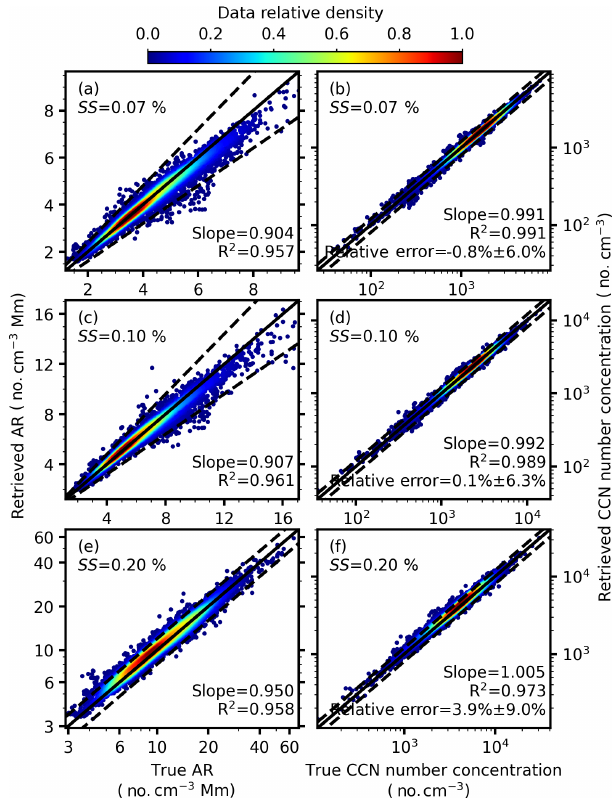
Figure 4. Comparison of the theoretical calculated extinction- related CCN activation ratio at 532nm (true AR) and the model- predicted extinction-related CCN activation ratios at 532nm (re- trieved AR) at supersaturations of (a) 0.07%, (c) 0.10%, and (e) 0.20%, and comparison of the theoretical calculated CCN number concentrations (true CCN number concentration) and the retrieved CCN number concentrations at supersaturations of (b) 0.07%, (d) 0.10%, and (f) 0.20%. A total of 80575 pairs of data calculated from campaign C5 are used. The solid line is the 1 : 1 line, and the dashed lines are 20% relative difference lines. Colors represent the relative density of the data points normalized by the maximum data density of each panel. The relative error shown in the figure is mean value ± 1 standard deviation.